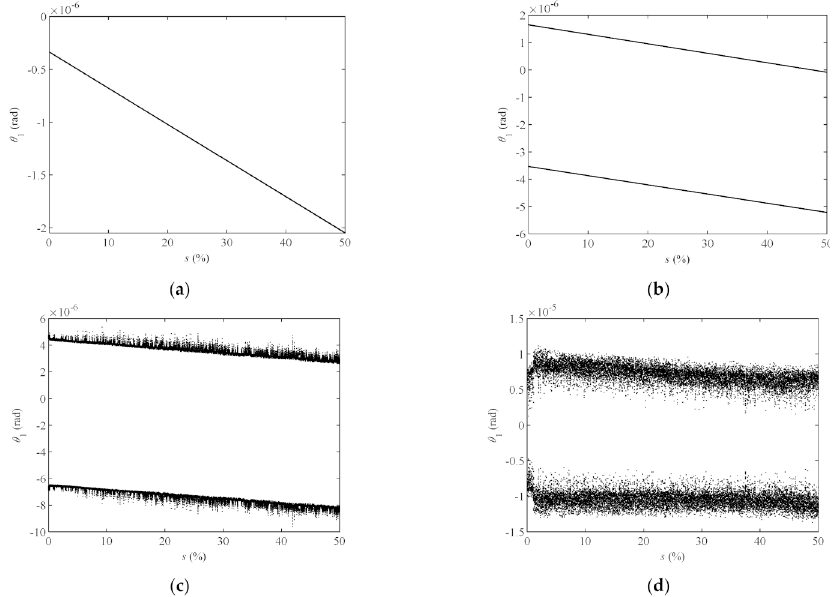
Figure 12. Bifurcation diagrams varying with s at different speeds: ( a ) ω = 500 rad/s; ( b ) ω = 800 rad/s; ( c ) ω = 1100 rad/s; ( d ) ω = 1800 rad/s. Figure 13 is a waterfall diagram about the polarization angle displacement of disk 1 varying with the tie rod looseness rate s at different speeds. When the rotating speed is at 500 rad/s, the spectrum diagram has components at one time and two times. At 800 rad/s and 1100 rad/s, the spectrum diagram has an additional component at half rotating frequency. At 1800 rad/s, in addition to the above components, the spectrum diagram has component at three times the rotating frequency and side-band components.